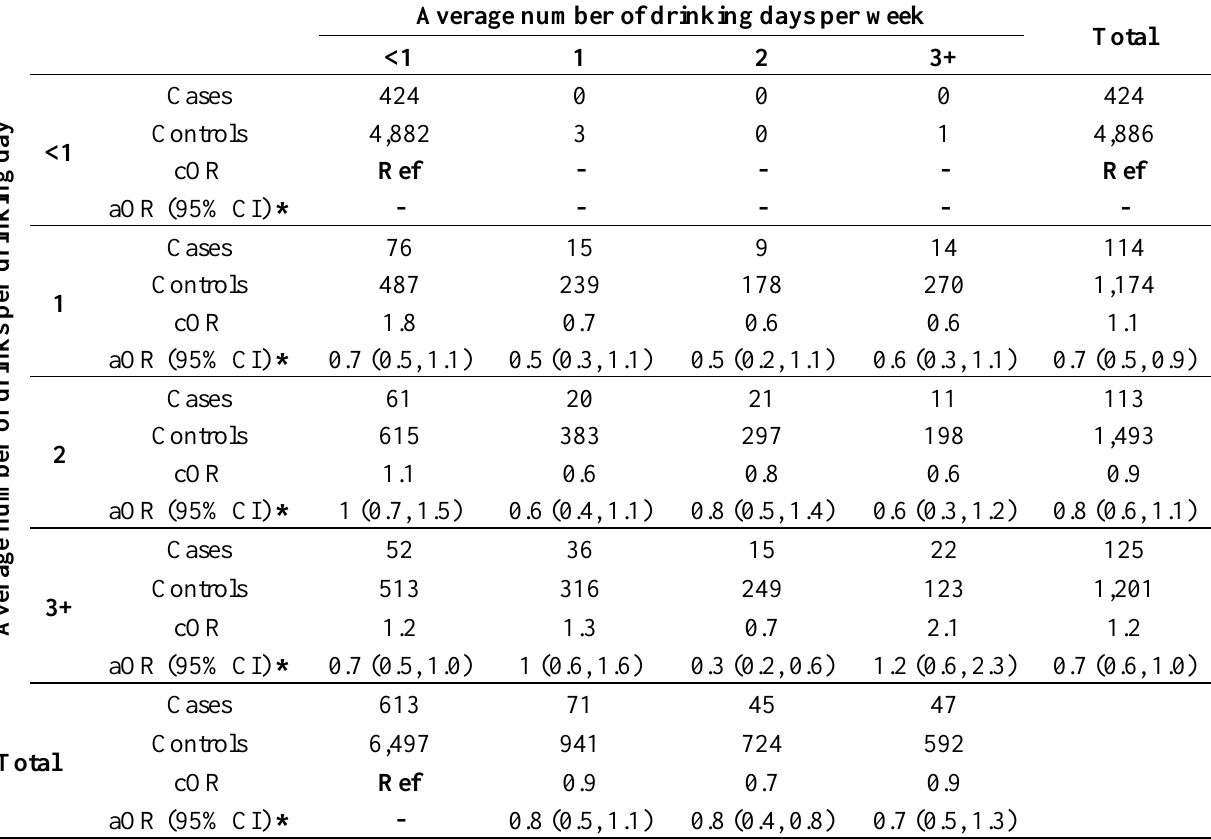
Table 4. Association between Spina Bifida and Alcohol Consumption by Frequency and Intensity During the First Month of Pregnancy, Birth Defects Study,